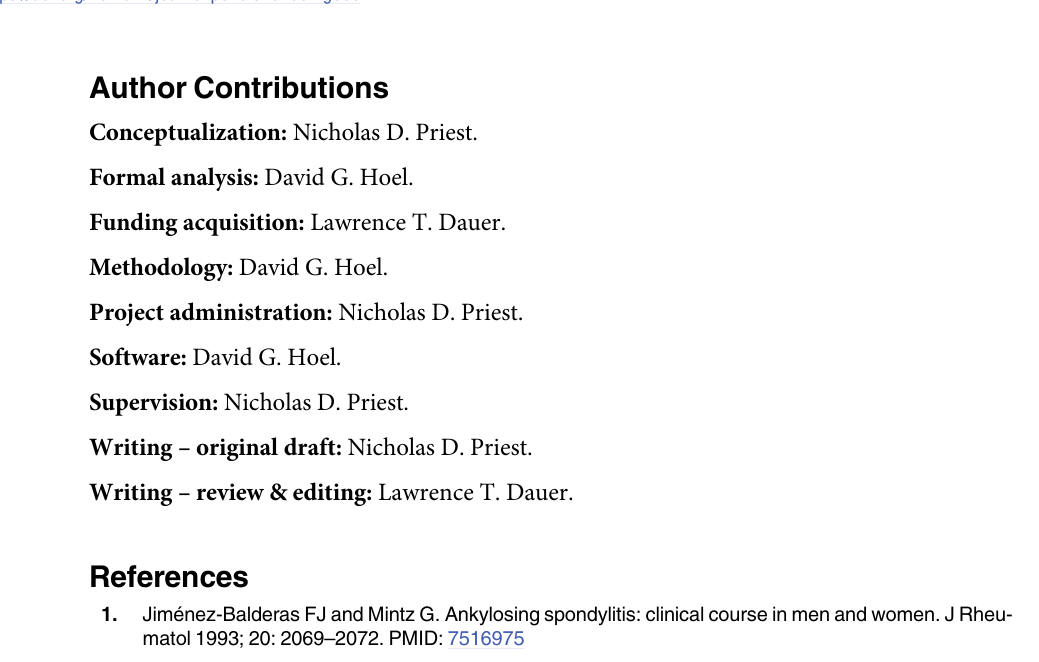
Fig 6. The percent recorded causes of death in controls (black) all radium-treated males (dark grey) and in patients that received the typical dose of radium (light grey) by ICD 07 code.